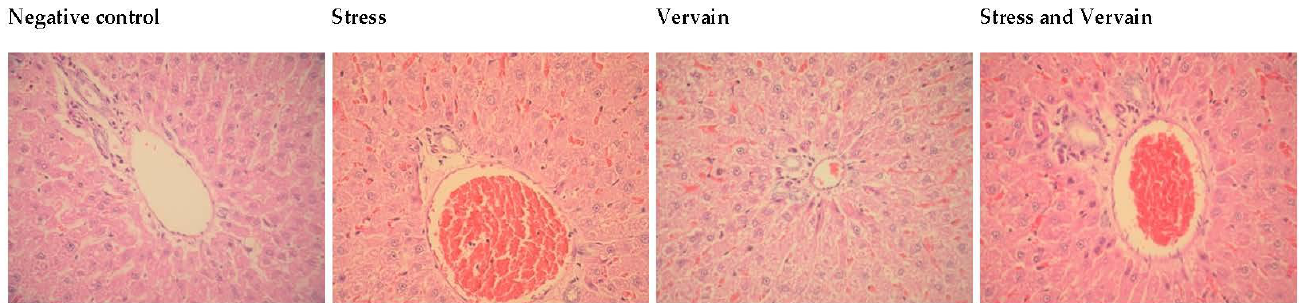
Figure 8. Liver histology under different treatment conditions, H.E. staining, 400×. The first figure represents a normal hepatic structure of animals maintained under normal conditions. The application of stress stimuli to the animals affected the liver histology, particularly via recurrent inflammation and altered hepatocyte structure. The herbal extract was unable to restore normal hepatic morphology in subjects under chronic stress.